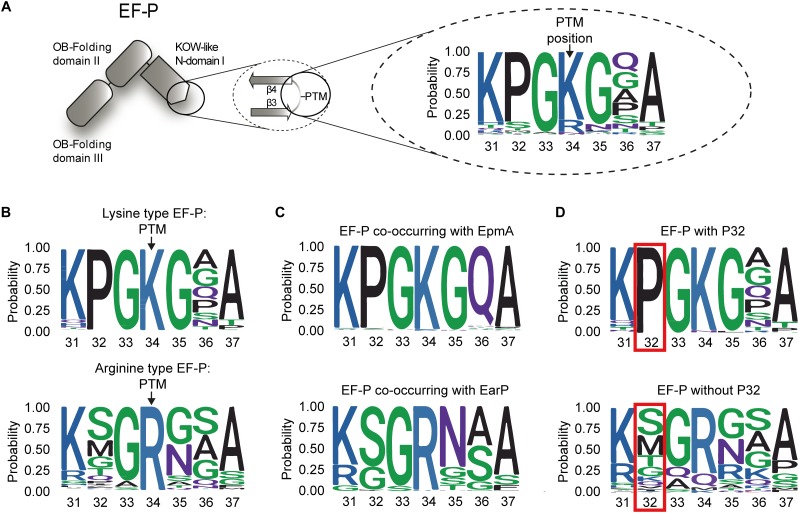
Composition of β3Ωβ4 of the EFP_N superfamily (A) Domain architecture of EF-P: The first magnification illustrates β3Ωβ4 of the KOW-like EF-P_N-domain I including the post-translational modification (PTM) site. The second magnification depicts the general amino acid composition of the seven amino acid long loop between the strands β3 and β4 based on 1166 sequences. (B) Weblogo of β3Ωβ4 for the EF-Ps with lysine (lysine-type EF-P, upper logo) or an arginine (arginine-type EF-P, lower logo) at position 34 according to the numbering of the E. coli ortholog. (C) Weblogo of β3Ωβ4 for the EF-Ps of bacteria co-occurring with EpmA (upper logo) or EarP (lower logo). (D) Weblogo of β3Ωβ4 for the EF-Ps containing (upper logo) or not containing (lower logo) a proline at position 32 according to the numbering of the E. coli ortholog.